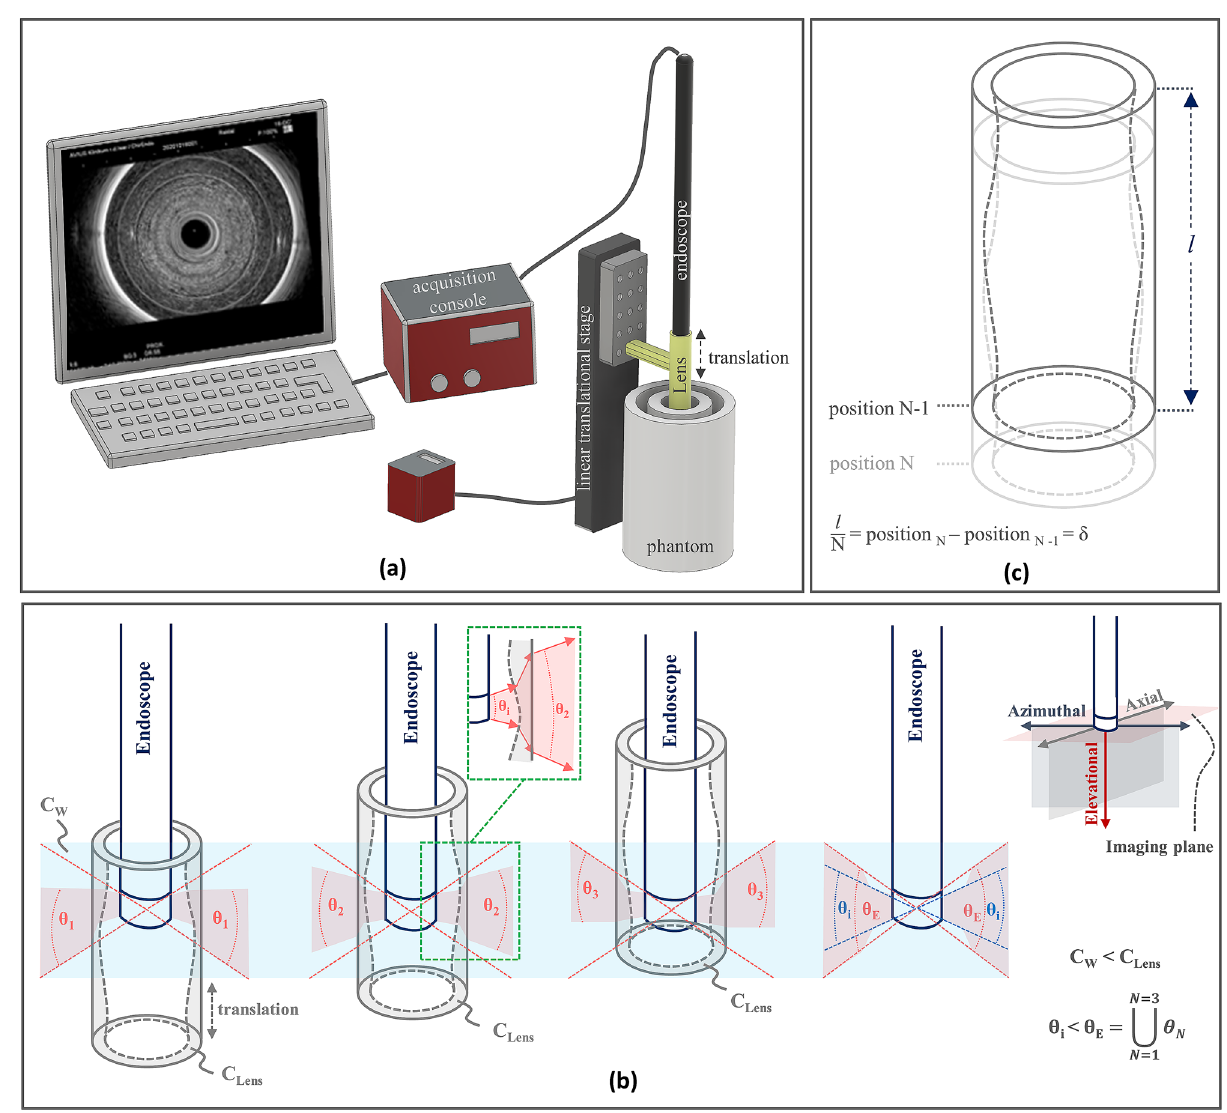
Figure 1. REACT implementation in EUS. (a) REACT imaging acquisition configuration using radial transducer array. Linear translation of the annular-shaped acoustic cylindrical lens along the elevational direction in front of the stationary radial transducer array controls the elevational angular FOV. (b) Elevational angular steering in different positions of the acoustic cylindrical lens. Sound waves propagate through the water and lens substrate at speeds of c w and c Lens , respectively, where c w < c Lens . Example of an incidence angle and refracted angle through the lens shown in the inset. The total elevational angular FOV of the transducer (θ E : union set of refracted elevational angular views from all positions of the acoustic lens) compared to its inherent elevational angular FOV (θ i ) is extended. (c) Schematic of annular-shaped acoustic cylindrical lens. The annular-shaped acoustic cylindrical lens is moved in consistent step sizes (δ), which are equal to the length of the acoustic lens ( l ) divided by the number of recorded images (N) for